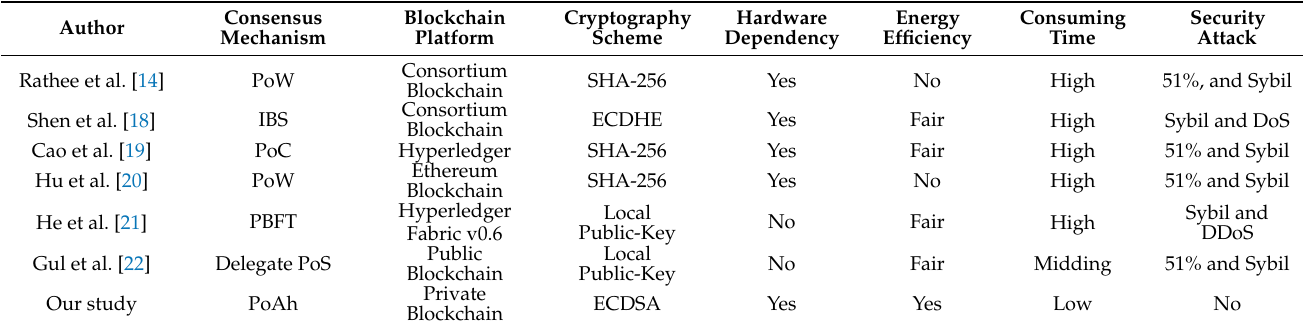
Table 3. Performance comparison of our study with